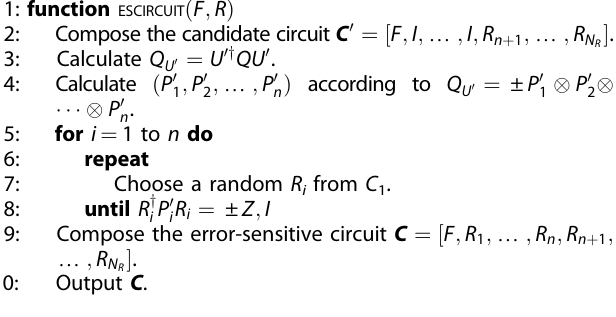
Algorithm 1 . Generation of error-sensitive circuits . 1: function ESCIRCUIT ð F ; R Þ